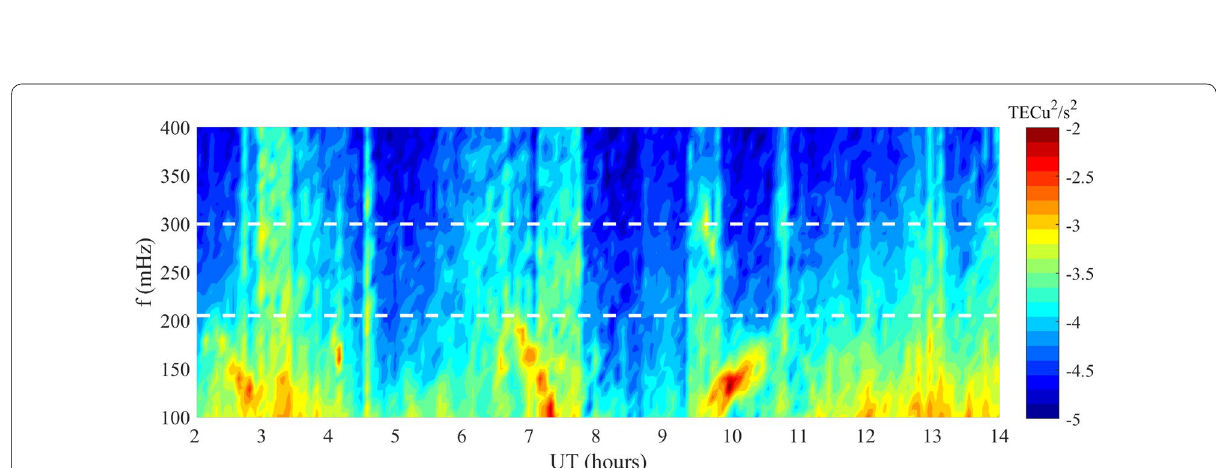
15.8). The black contour indicates the SNR(f) greater than 3 at MZS =